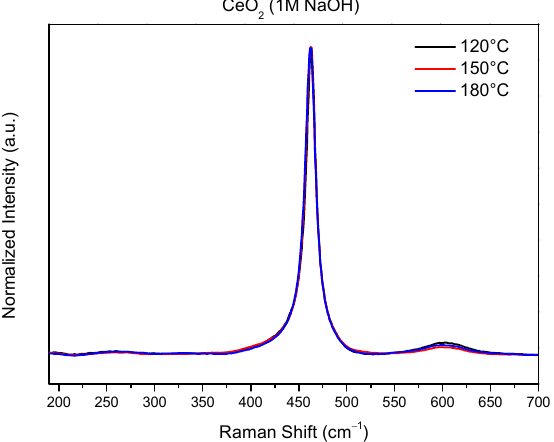
Figure 5. Raman spectra of pure ceria samples.